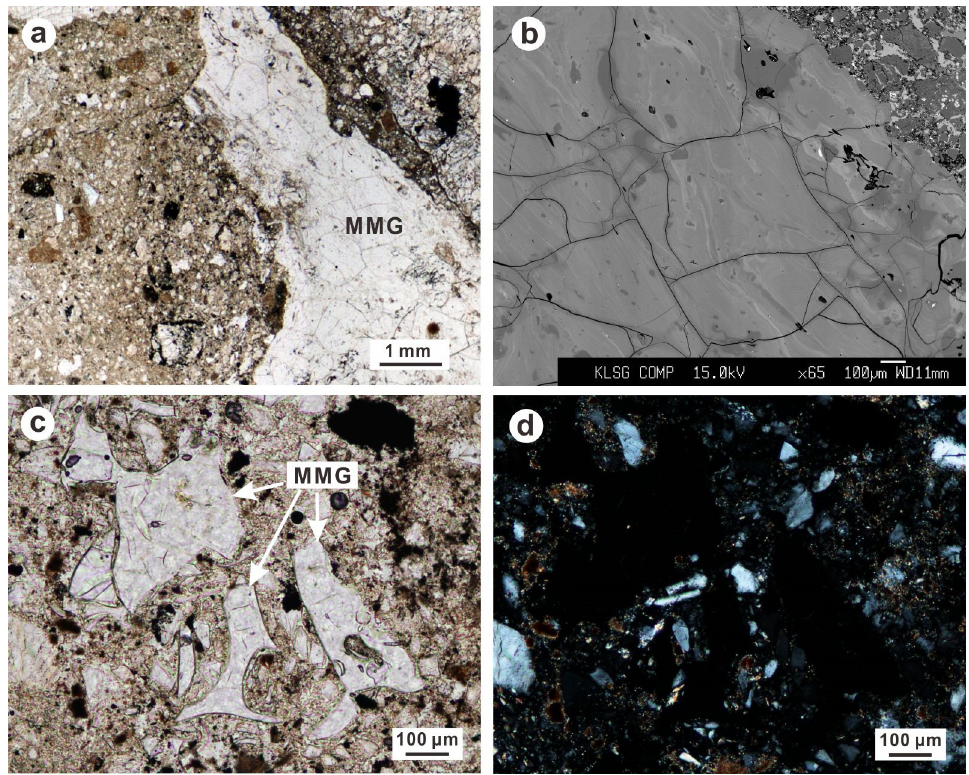
Figure 7. ( a ) A large MMG in the suevite (PPL). ( b ) BSE image of MMG shows schlieren and irregular fractures. ( c , d ) Some small MMGs have irregular shapes and are extinct under XPL.